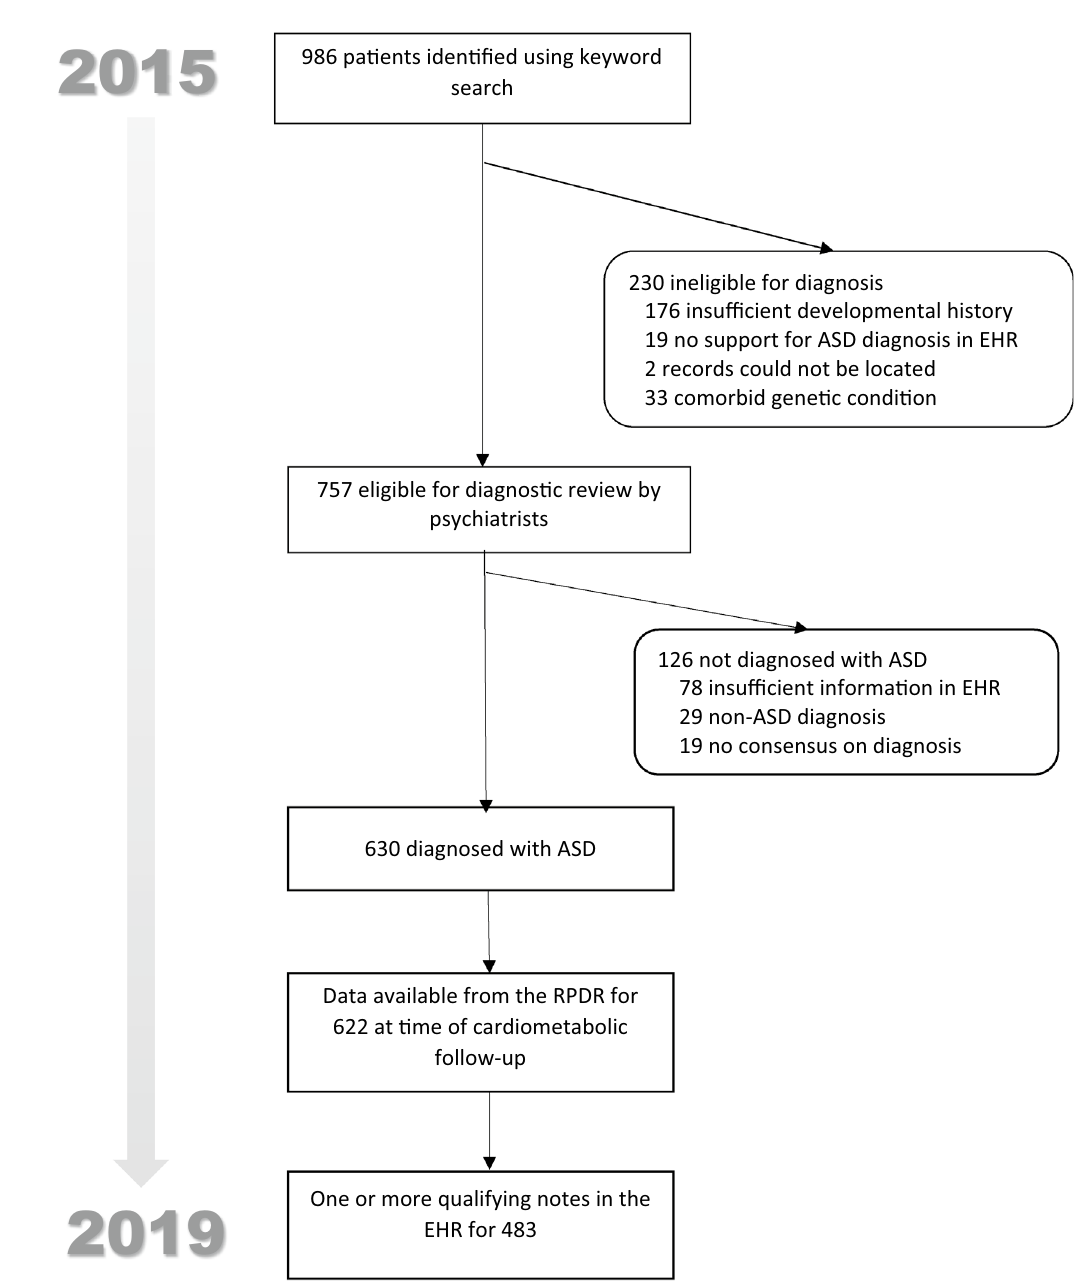
Figure 1. Number of patients meeting eligibility criteria for original study and cardiometabolic follow-up study. ASD autism spectrum disorder, EHR electronic health records, RPDR research patient data Prevalence of risk factors for cardiovascular disease. Across age groups and categories of race and ethnicity, prevalence of overweight was 133/478 (28%; 95% CI 24%, 32%) overall, 105/371 (28%; 95% CI 24%, 33%) for men, and 28/107 (26%; 95% CI 19%, 35%) for women. Prevalence of obesity was 168/478 (35%; 95% CI 31%, 40%) overall, 131/371 (35%; 95% CI 31%, 40%) for men, and 37/107 (35%; 95% CI 26%, 44%) for women; and prevalence of severe obesity was 23/478 (5%; 95% CI 3%, 7%) overall, 20/371 (5%; 95% CI 4%,